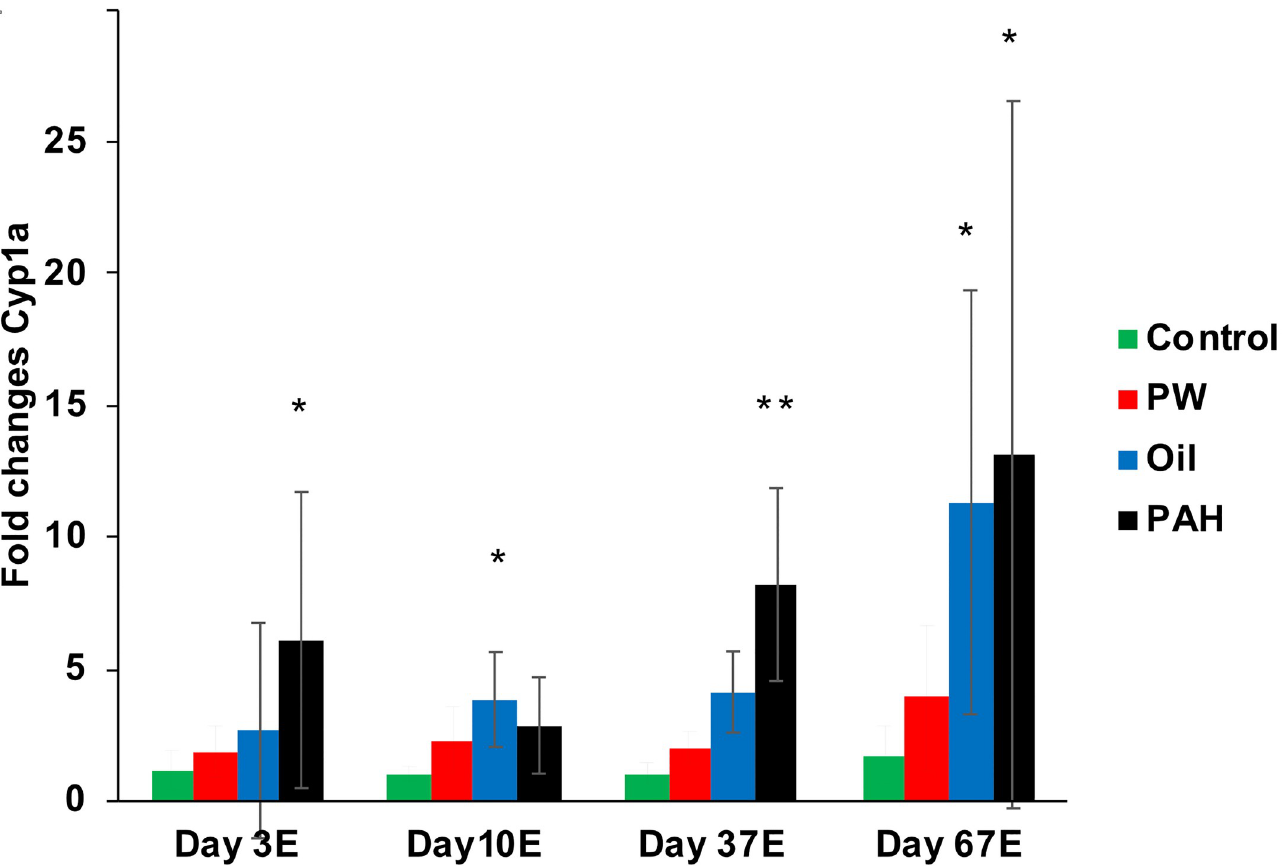
Fig 8. Gene expression of cyp1a in liver after 3 day (one dose), 10 days, 37 days and 67 days of oral exposure. Data presented as means ( ± SD). ( � ) indicate significant differences compared with control, p < 0.05.